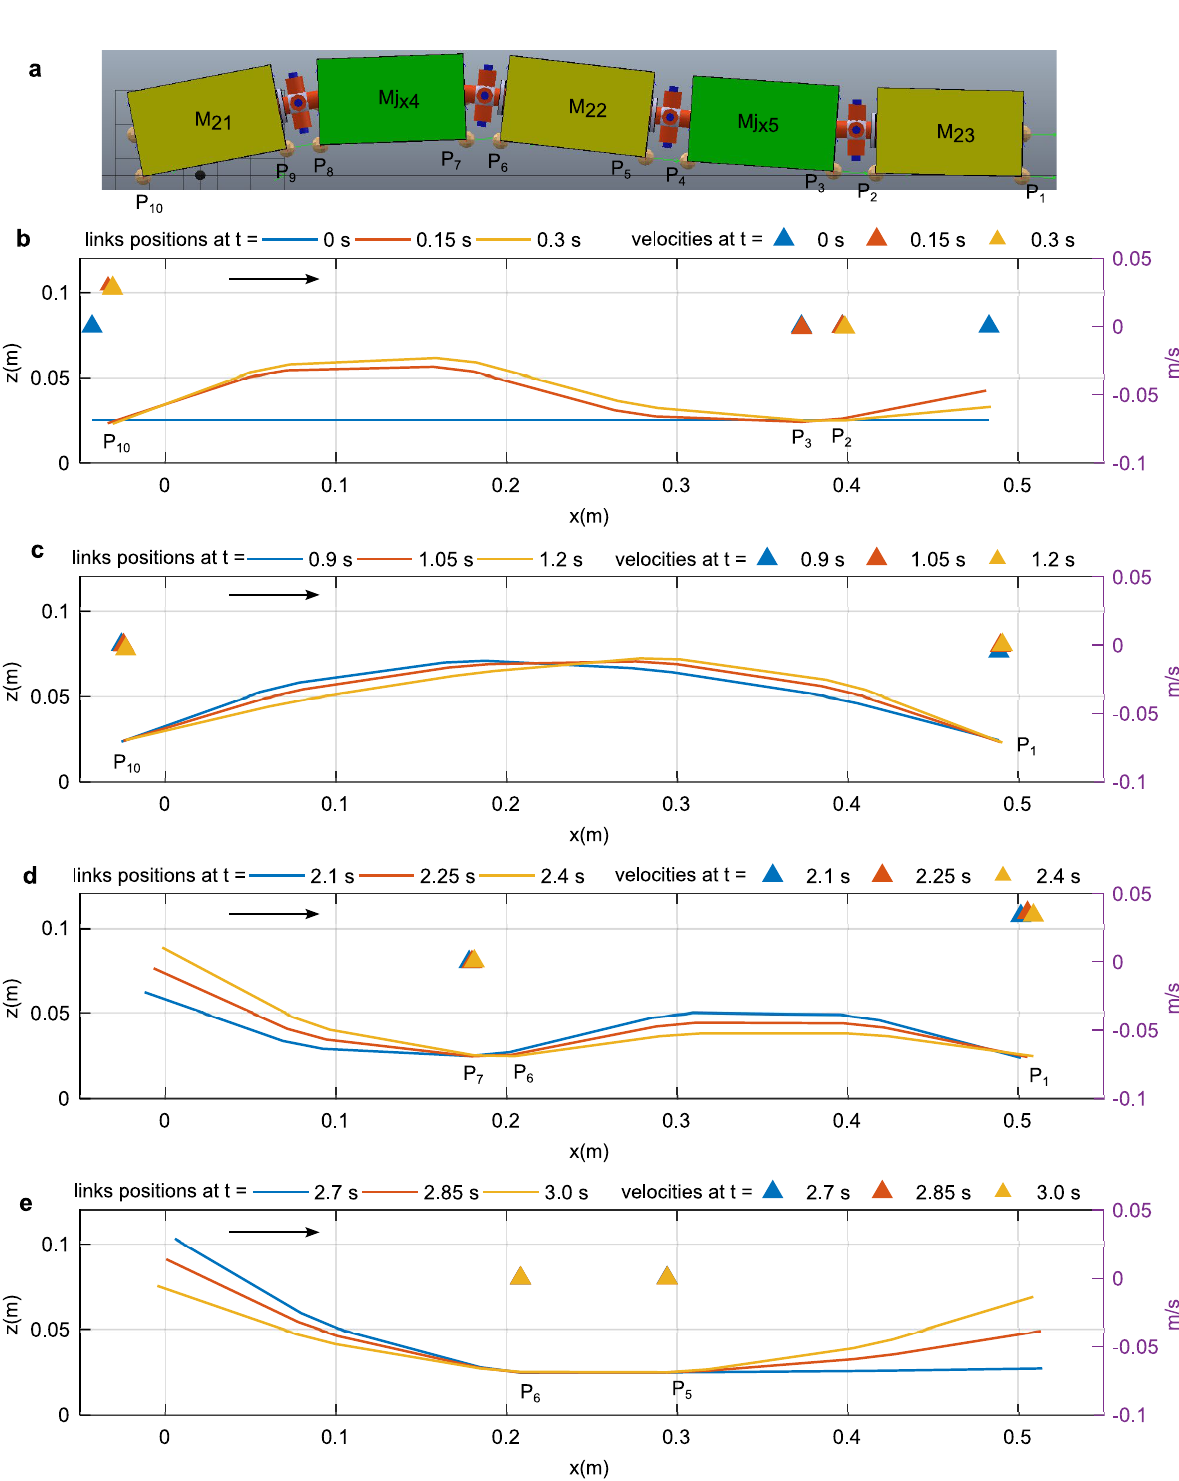
Fig. 13 In translational locomotion simulation, the link locations and velocities at the ground contact points of WORMESH-II with respect to time t (wave parameters are A = 0.05 π , ω = 0.5 π , and β = 4 π/ 3 ). a Terminology of ground contact points. b Anchor-pull movement. c From Anchor-pull to Anchor-push. d Anchor-push movement e From Anchor-push to Anchor-